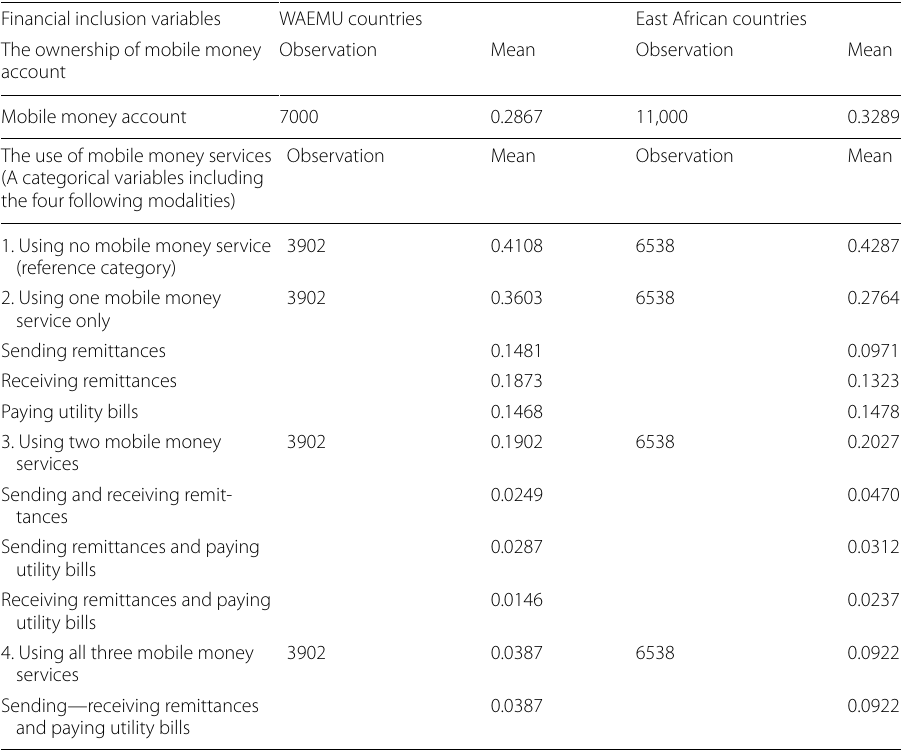
Table 3 Descriptive statistics of financial inclusion measures. Source : Author’s calculations